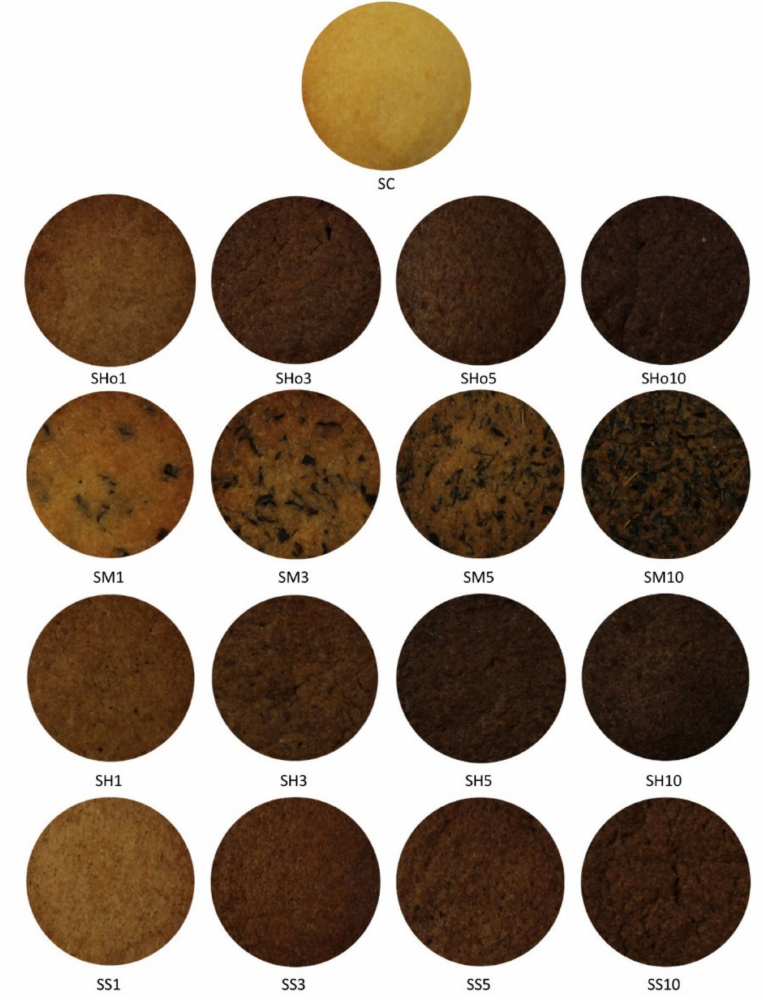
Figure 1. Colour changes of biscuits depending on the addition of spices/herbs. SC, control biscuit; SHo, biscuit with added grape seed flour (0, 3, 5, or 10%); SM, biscuit with added mint (0, 3, 5, or 10%); SH, biscuit with added clove (0, 3, 5, or 10%); and SS, biscuit with added cinnamon (0, 3, 5, or 10%). p < 0.05 p < 0.05 p <